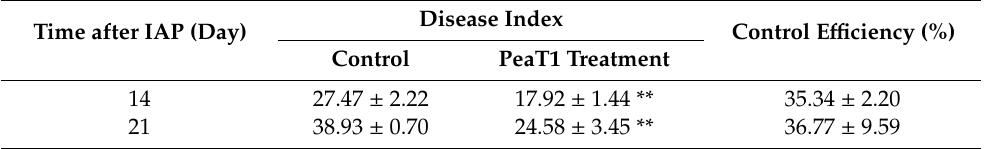
Table 2. Control e ffi ciency of PeaT1 on BYDV indoor.